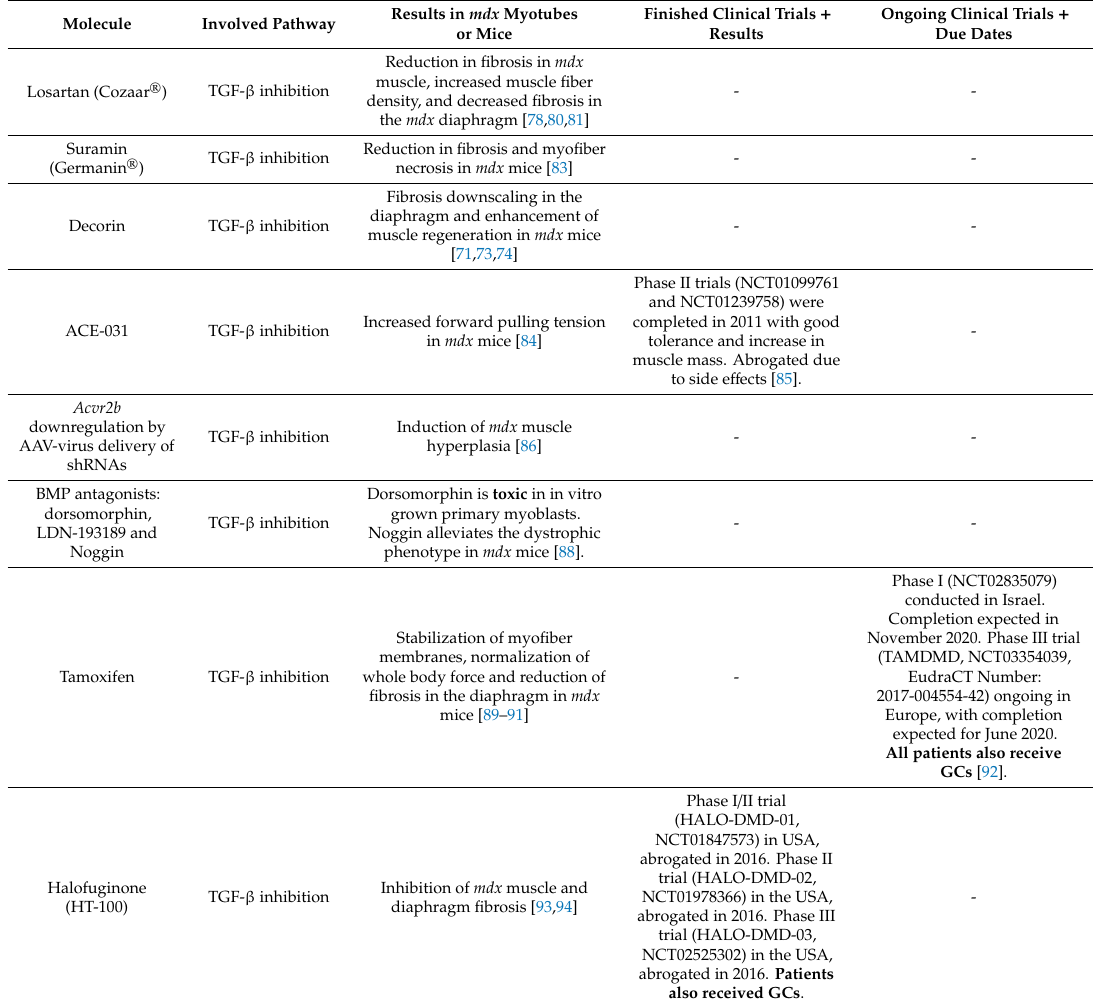
Table 5. Overview of tumor growth factor β (TGF- β ) or myostatin stabilizing molecules: results in mdx myotubes (in vitro) or mice (in vivo), finished clinical trials and results, ongoing clinical trials and due dates, and putative